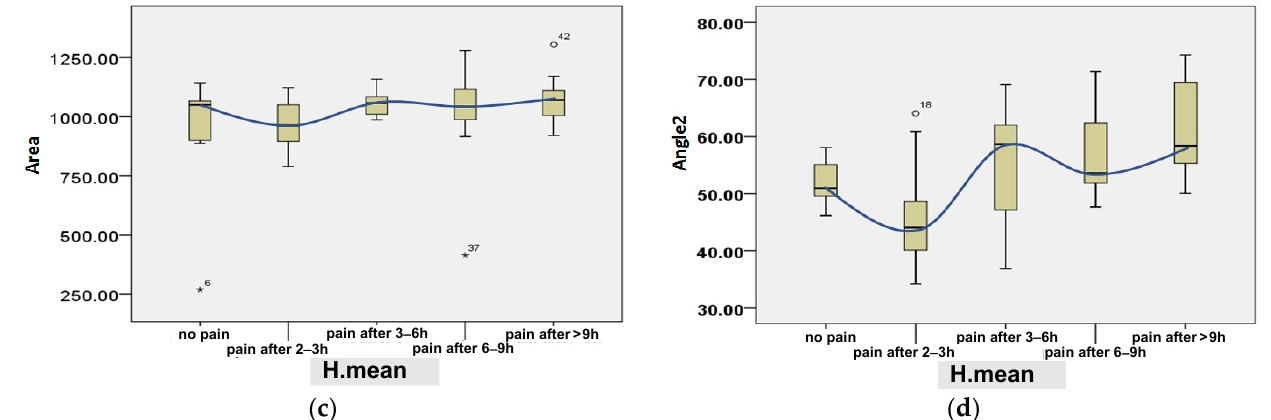
Figure 7. Effect of SM usage examined by time duration (i.e., H.mean) on age ( a ), angle_1 ( b ), area ( c ), and angle_2 ( d ). In Figure 7a for the variable age, the following values are reported: the first quartile Q1, that is the value below which 25% of the values in the data set are found, the median of the data values Q2, the third quartile Q3, that is the value below which 75% of the values in the data set are found, the interquartile range (IQR) = (Q3 − Q1) namely the middle 50% of the data set. The lower whisker is a line from Q1 to the smallest data point within the (1.5×IQR) range from Q1. The upper whisker is a line from the Q3 to the largest data point within the (1.5×IQR) range from Q3. The mild outliers, values smaller than [Q1 − 1.5(IQR)] or larger than [Q3+1.5(IQR)], represented by circles; the extreme outliers, values smaller than [Q1 − 3(IQR)] or larger than [Q3+3(IQR)], represented by stars. Outliers in data, regardless of whether they are legitimate or the consequence of errors, are generally worthy of investigation. Figure 7a's upper outliers, ages 19 and 26, indicate whether or not these patients, ages 19 and 26, had worked 3-6 h using SM devices. Instead, the patient being observed (*32) is an error, as it does not fall within the range of 6-9 h and is eliminated.